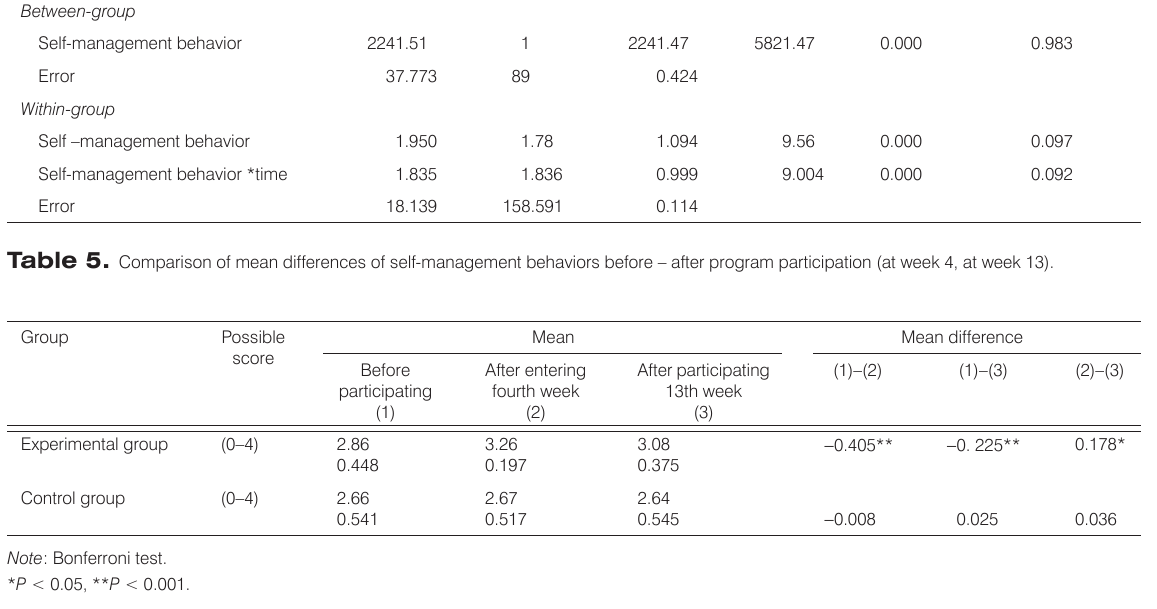
Table 6. Comparison of mean differences in self-management behavior scores before and after entering the Program (at the 4th & 13th weeks within each group).